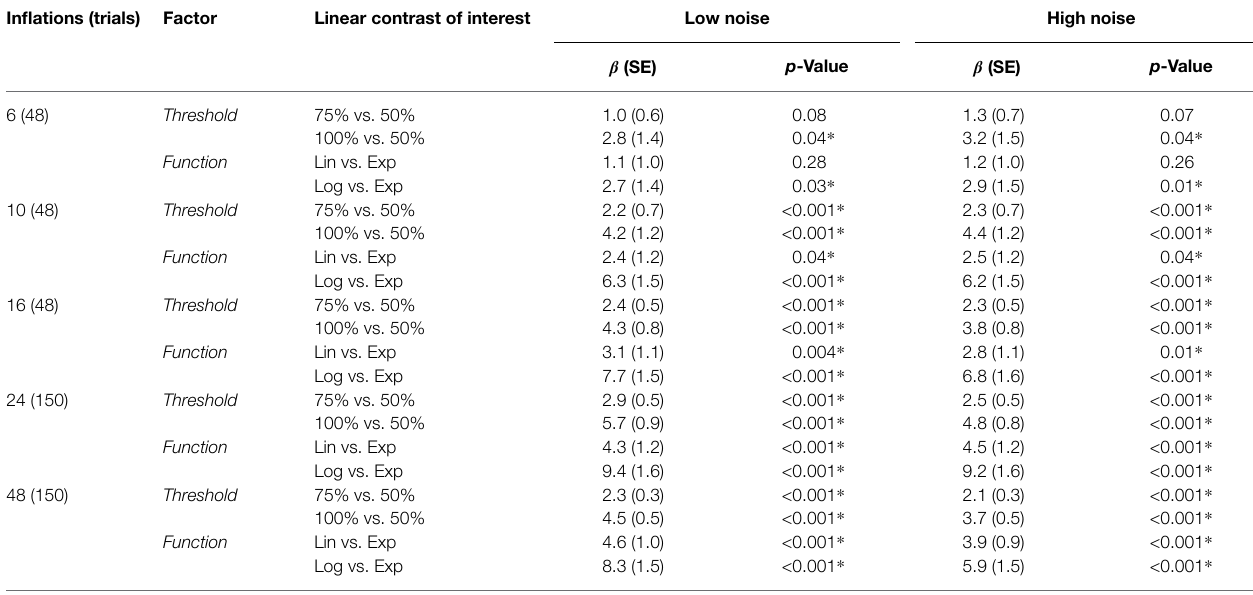
TABLE 1 | Direct contrasts showing the accuracy increase when using lower thresholds and exponential functions. Inflations (trials) Factor Linear contrast of interest Low noise High